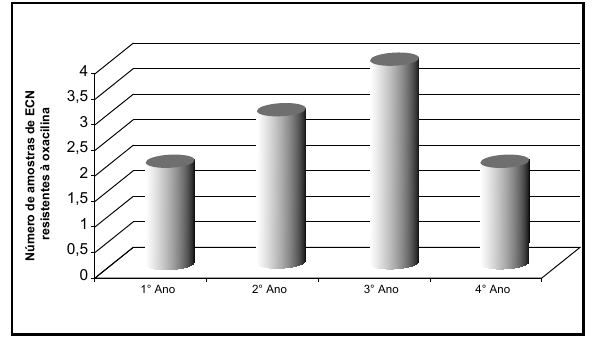
Figura 3 – Perfil de resistência à oxacilina em amostras de ECN isoladas das fossas nasais de alunos do primeiro ao quarto ano do curso de enfermagem da FMB ECN: estafilococos coagulase-negativos; FMB: Faculdade de Medicina de